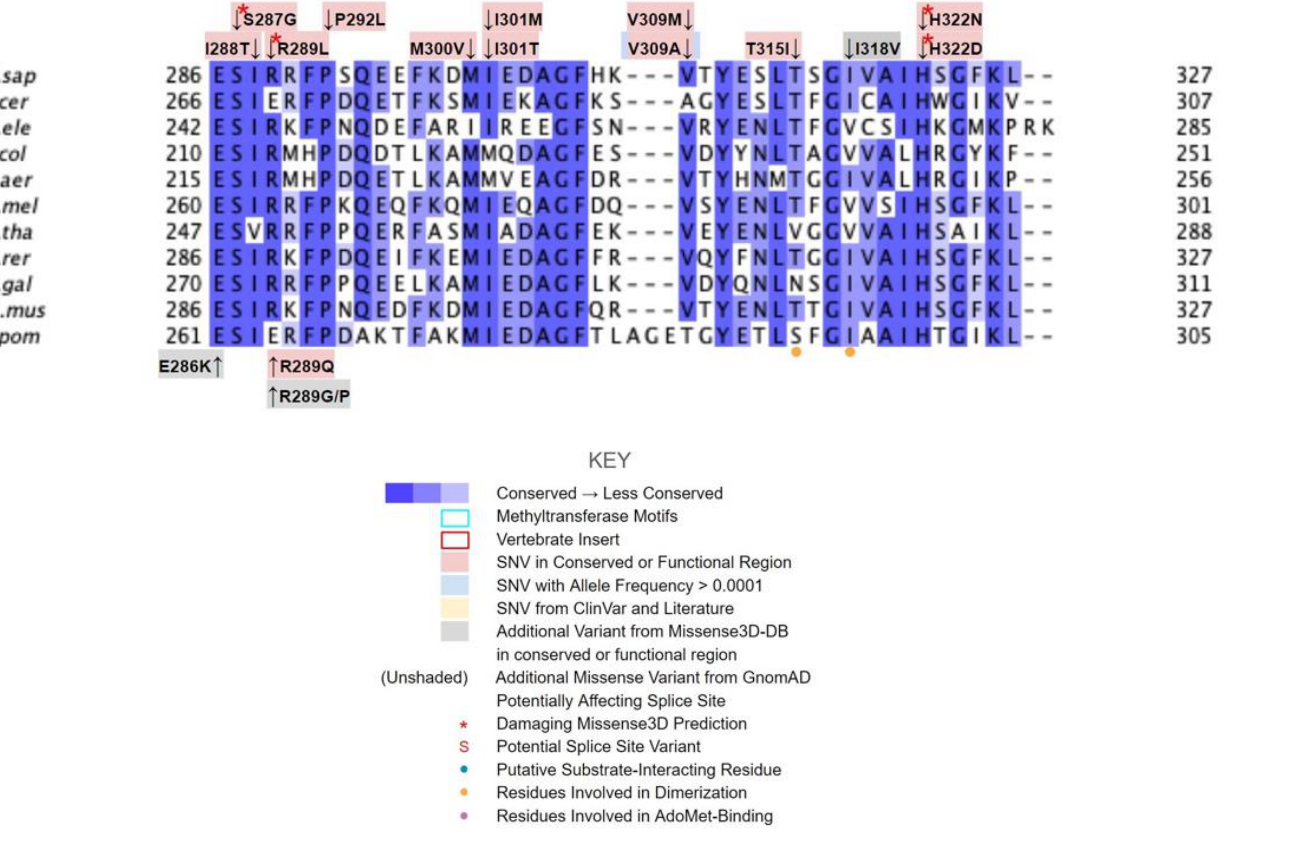
functional residue instead due to its similar aromatic nature.